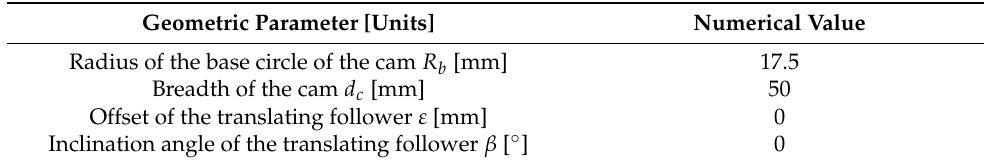
Table 1. Geometric parameters chosen for the design of the cam–follower